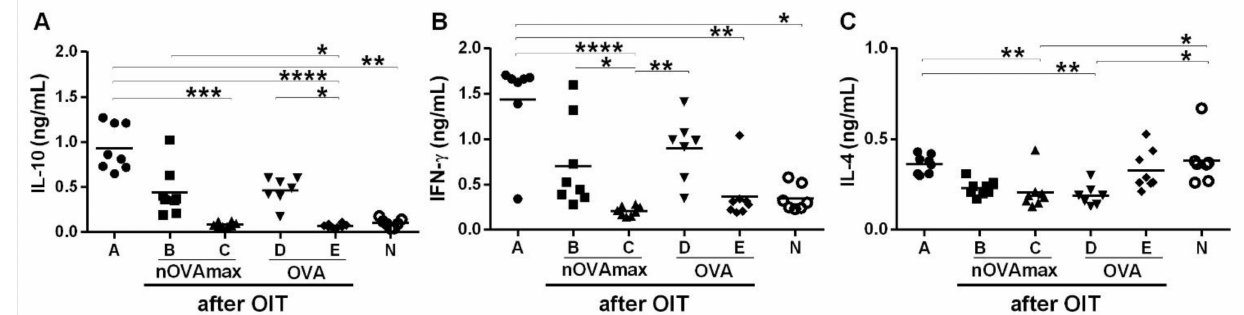
Figure 6. Cytokine release from the stimulated splenocytes. The spleens were isolated, and purified splenocytes were stimulated with 5 µ g/mL of OVA. The supernatants were collected, and cytokine ELISAs were performed. Graphs ( A – C ) show the results for IL-10, IFN- γ and IL-4, respectively. The values were analyzed using the Kruskal–Wallis non-parametric test with Dunn’s multiple correction (* p < 0.05, ** p < 0.01, *** p < 0.001, **** p < 0.0001).